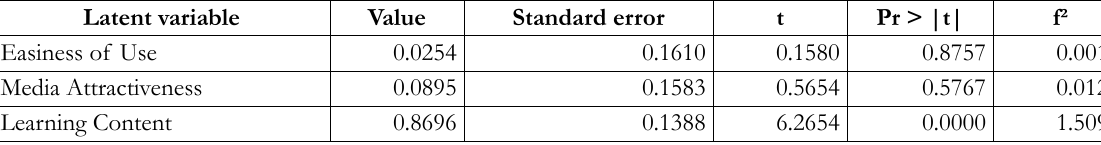
Table 4. Path coefficients of latent variables